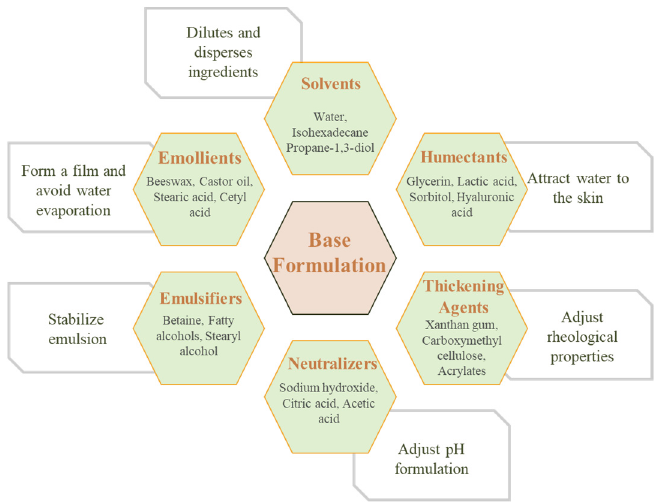
some examples of the compounds commonly used.